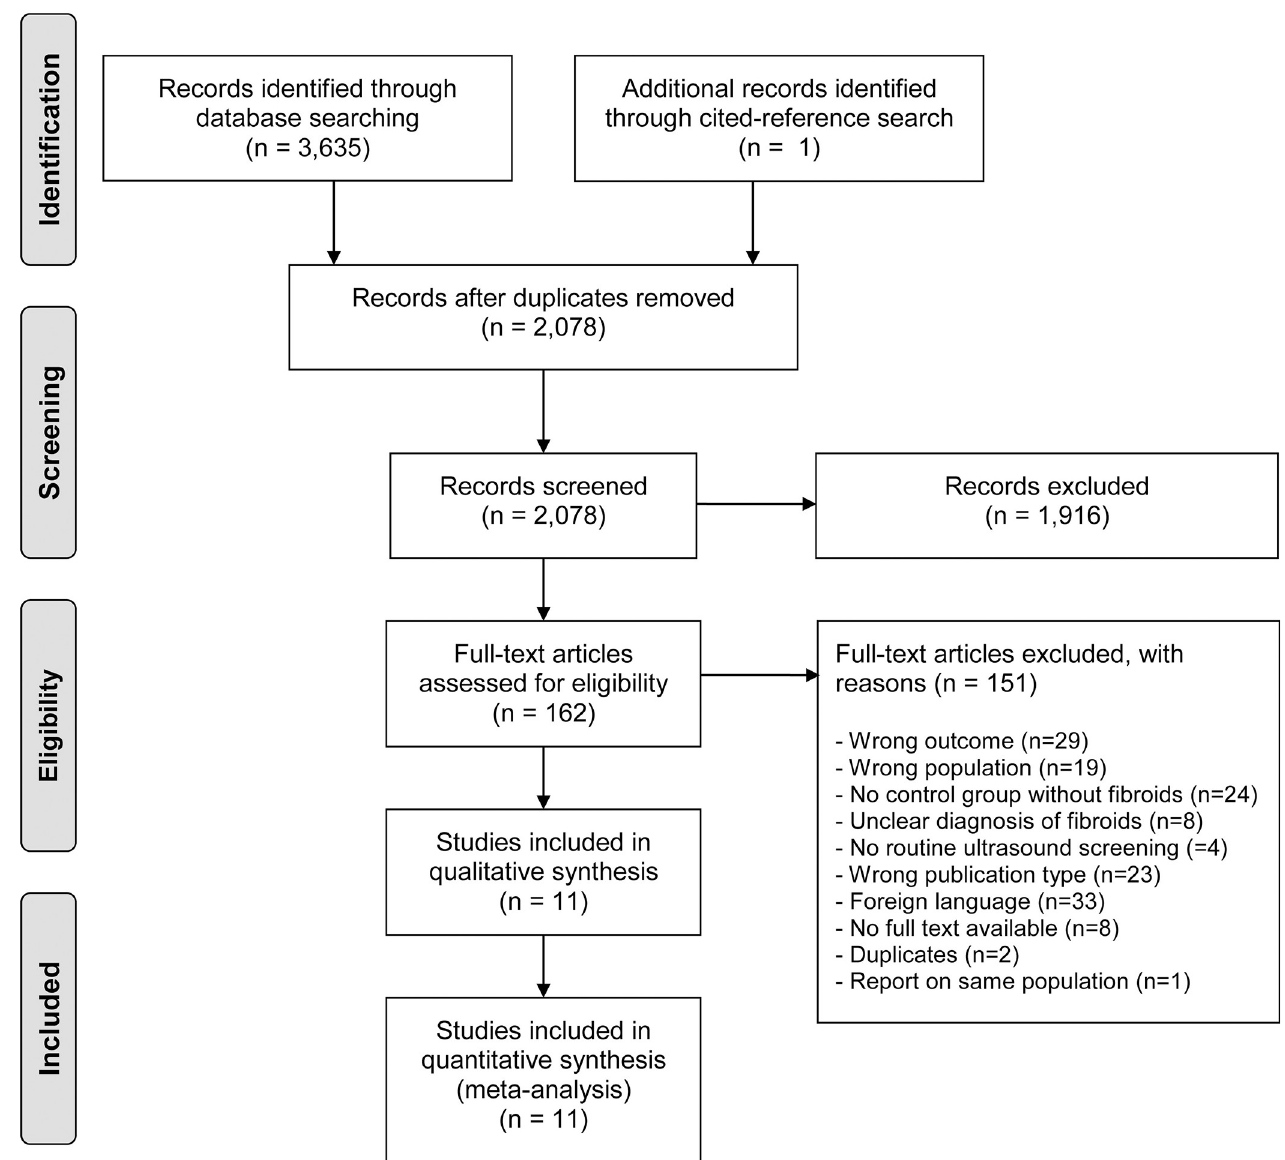
Fig 1. Flow diagram of study